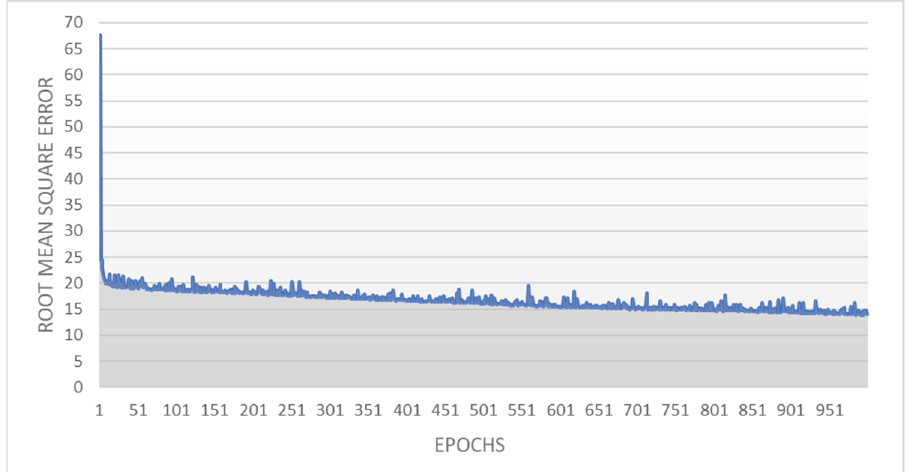
Figure 5. Root Mean Squared Error to Epochs for the Higher-Level Psychopathology Artificial Neural Network Model. Note. Depiction of the accuracy and learning rate of the higher-level psychopathology artificial neural network model used in this research. The grey area under the blue line represents the summed squared error of the model that after particular number of epochs.